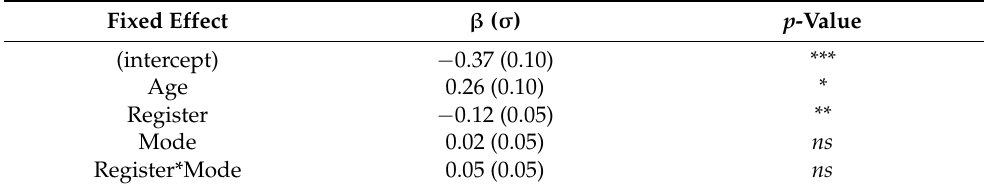
Table A1. Germany. Regression table for binomial GLMM with the dependent variable Connector and the independent variables Age, and the interaction of Register and Mode. Outputs for by-Country binomial GLMM.